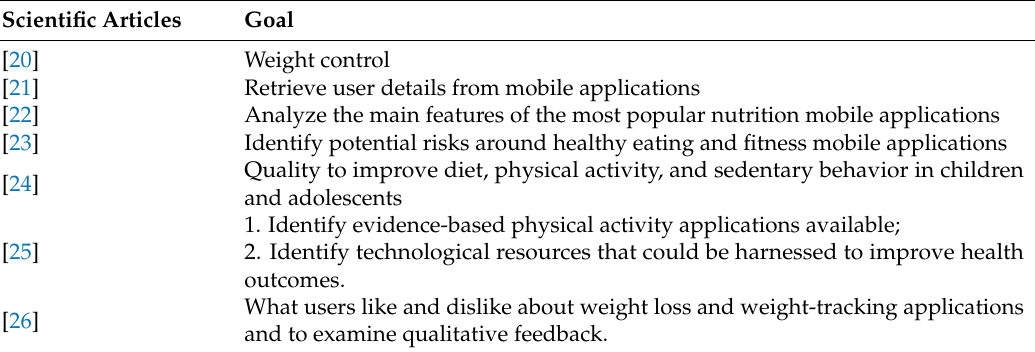
Table 5. Related work